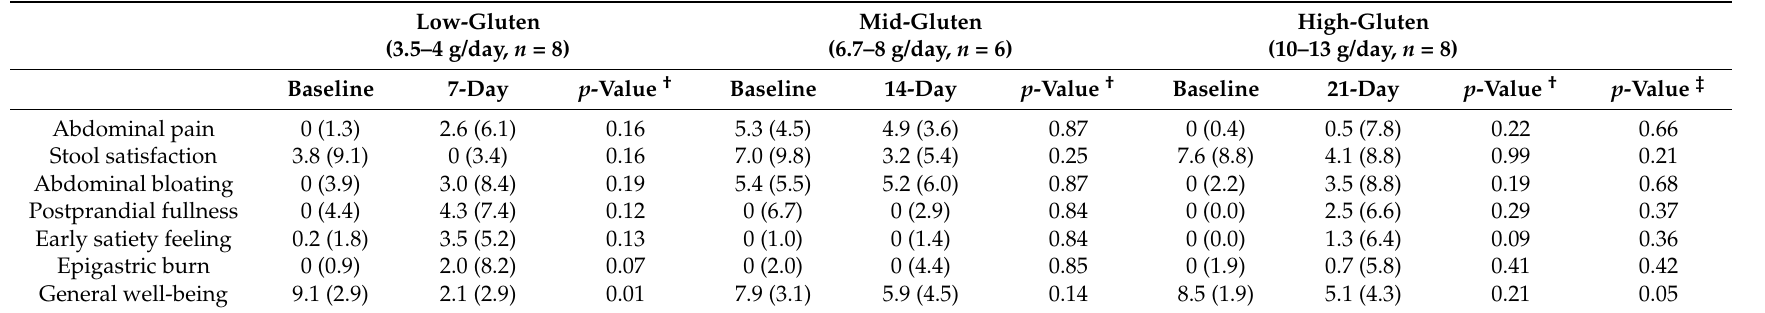
Table 5. Visual analogue scale scores for gastrointestinal symptoms 1